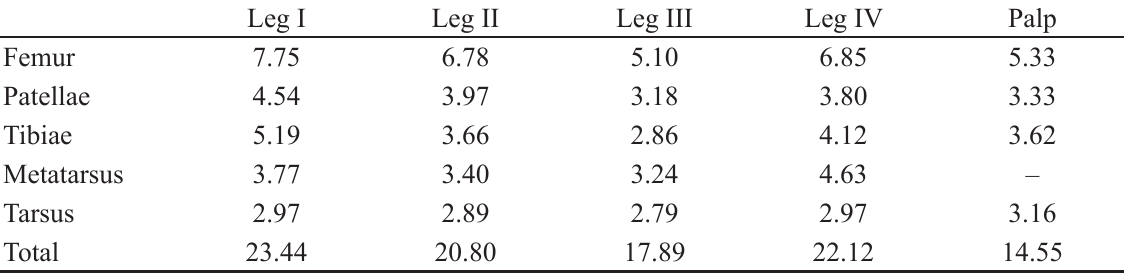
Table 2. Bistriopelma peyoi sp. nov., paratype, ♀ (MUBI 70); length of palpal and leg segments. Leg I Leg II Leg III Leg IV Palp Femur Patellae Tibiae Metatarsus – Tarsus 2.97